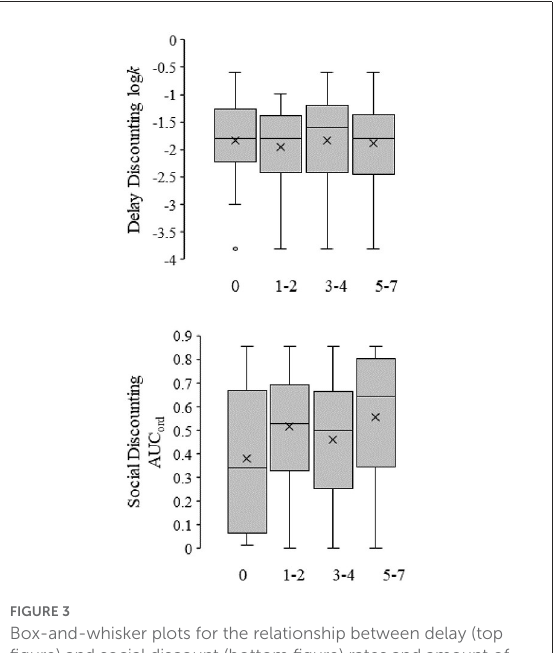
FIGURE3 Box-and-whisker plots for the relationship between delay (top figure) and social discount (bottom figure) rates and amount of exercise per week. Symbols are the same as in Figures 1, 2. The leftmost box represents individuals self-reporting no exercise ( n = 25), whereas subsequent boxes represent individuals self-reporting increasing amounts of exercise per week in ascending order ( n ’s; 1–2 = 71, 3–4 = 90, and 5–7 =